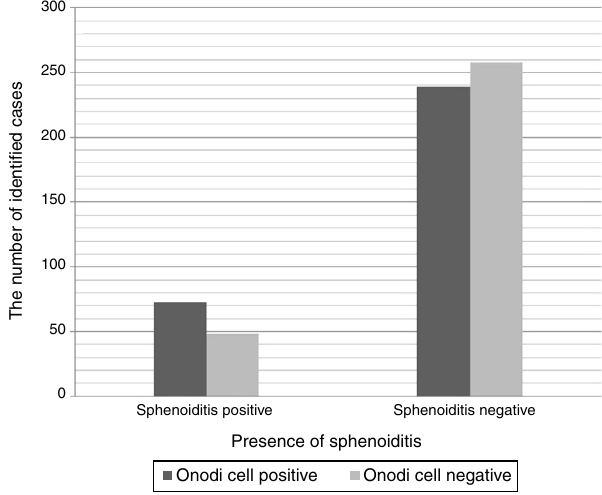
Figure 3 The graph shows that Onodi cell positivity causes a 1.5-fold increase in the number of cases with sphenoiditis ( p =